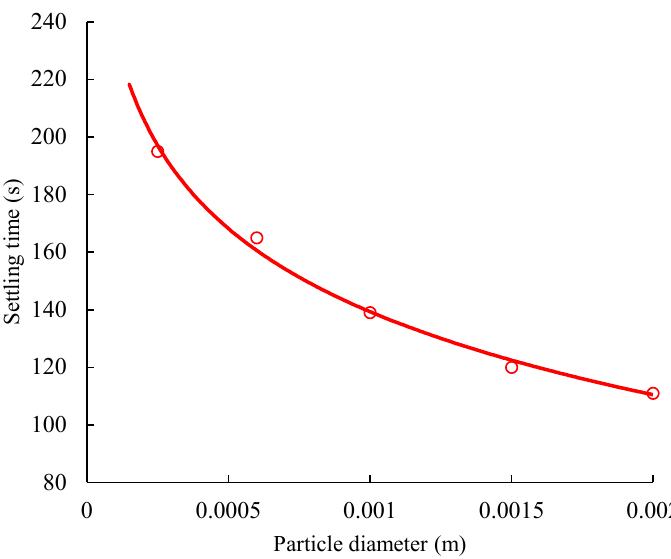
Figure 6. Settling time at different particle diameters.